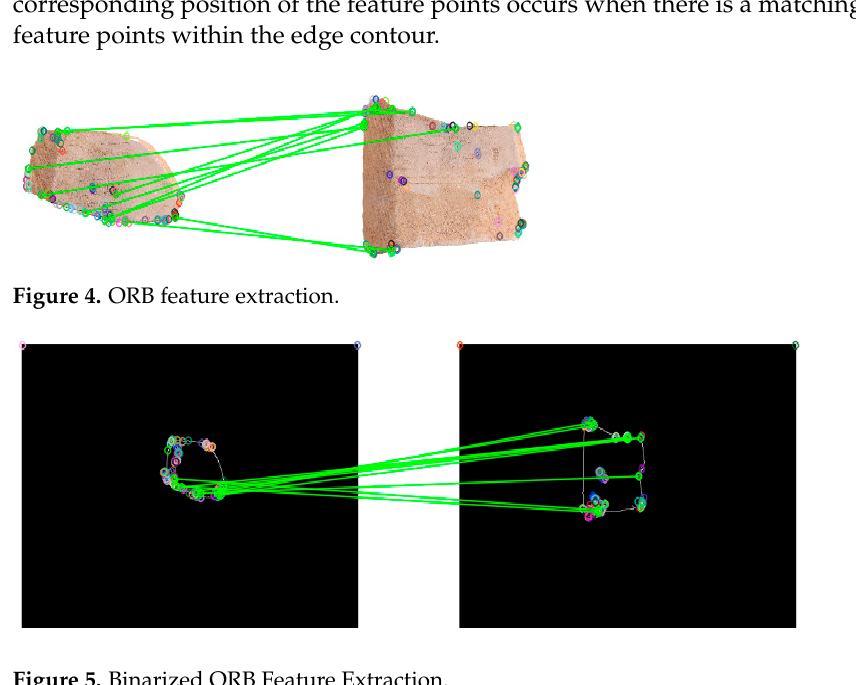
( b ) Down Figure 2. Canny edge detection. In order to highlight the edge pixels, the binarized image can reduce the pixel texture information inside the bone tag image. Figure 3 is the edge detection image of the Canny algorithm after binarization. Compared with Figure 2, the contour edge texture is more obvious, and there is not too much texture information in the image. When extracting feature points, the accuracy of matching points is improved. Reduce the impact of noisy environments. ( a ) Top ( b ) Down Figure 3. Binarized Canny edge detection.